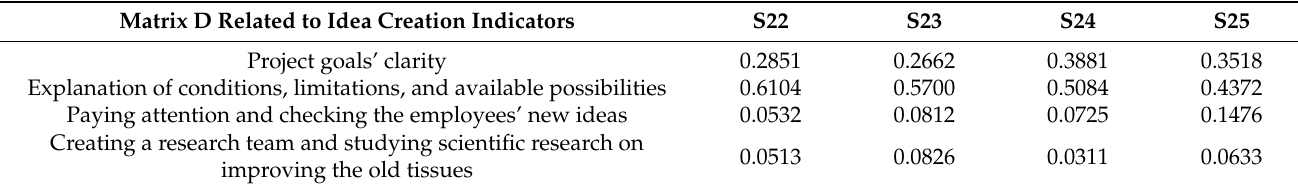
Table 21. The normalized matrix related to idea creation